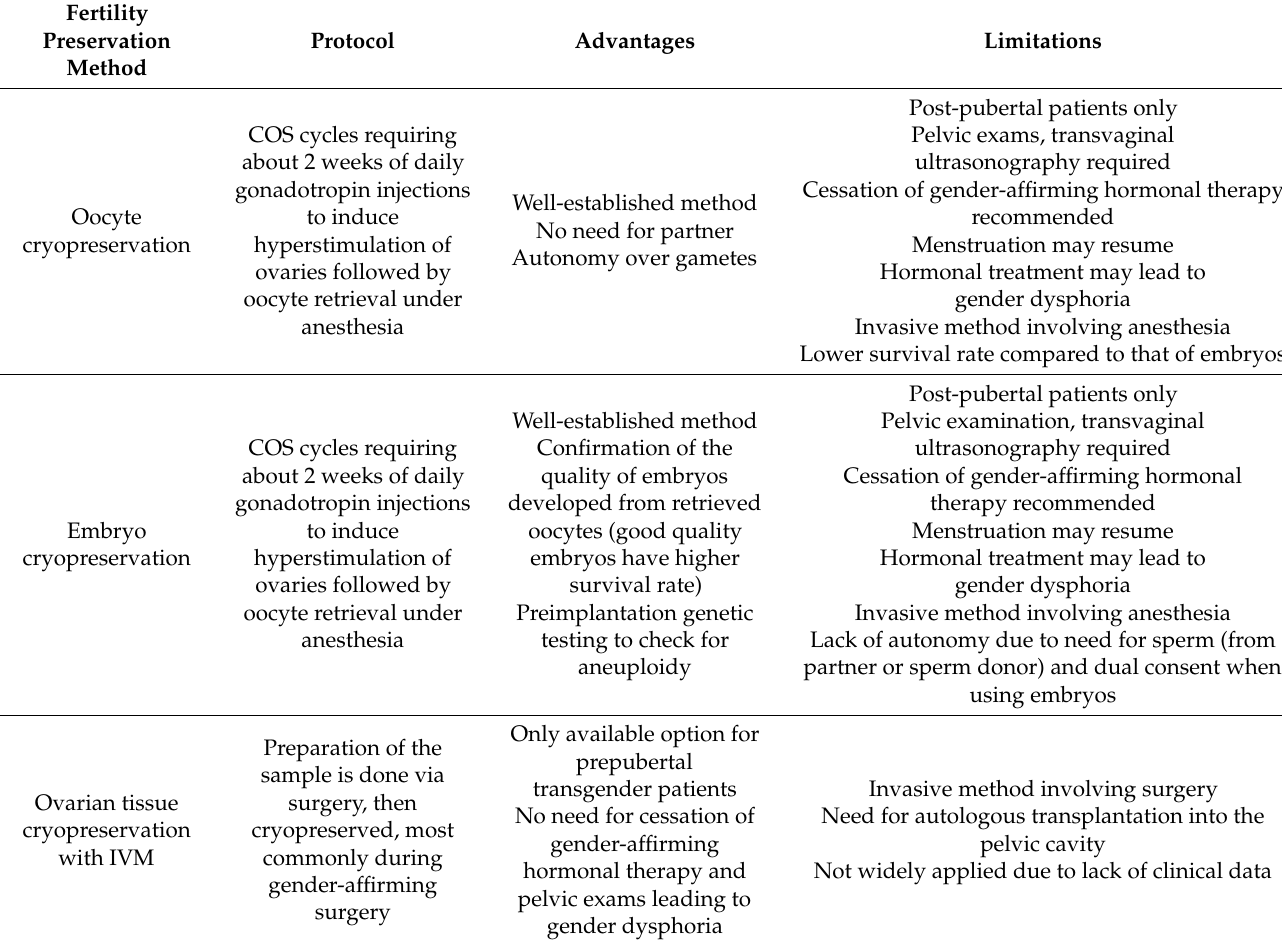
Table 1. Fertility preservation options for